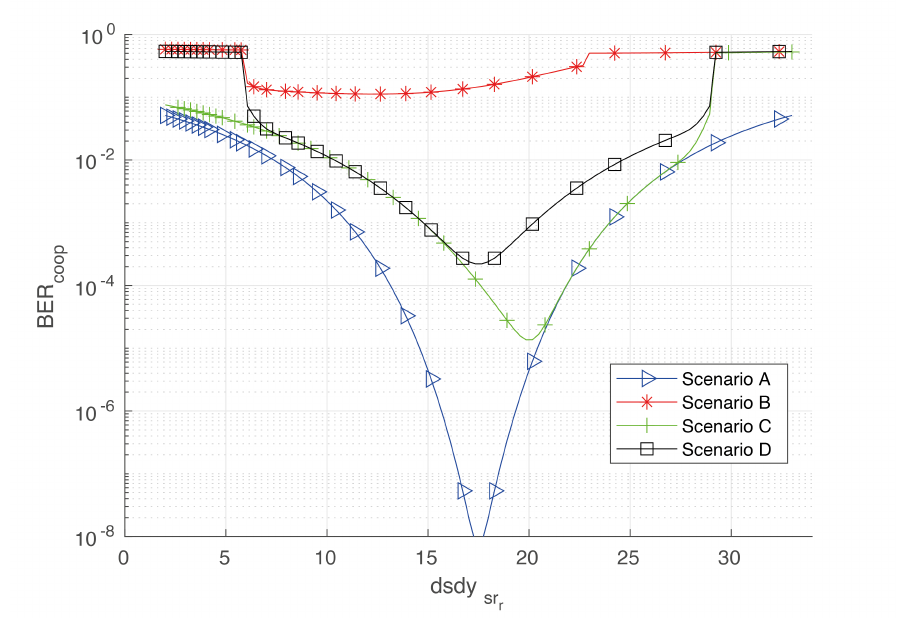
Figure 6. Cooperative bit error rate (BER) for different scenarios. Calculations were made varying dsdy sr between S and D , which were considered 40 m apart from each r